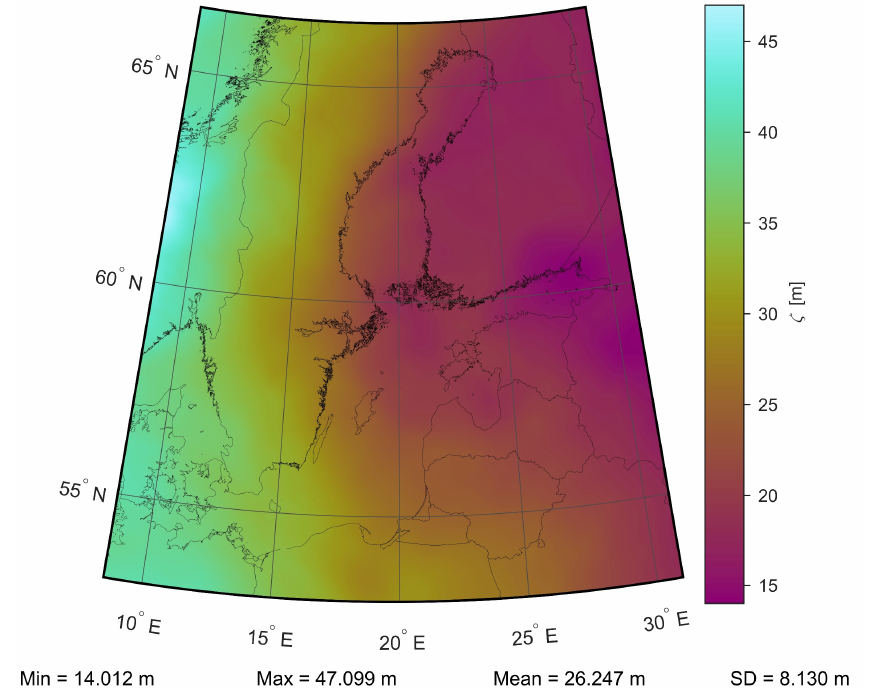
Figure 14. Gravimetric geoid modeling solution of the Baltic Sea region. GGM: GOCO05c, modification limits: 200, bathymetry was considered in computations.